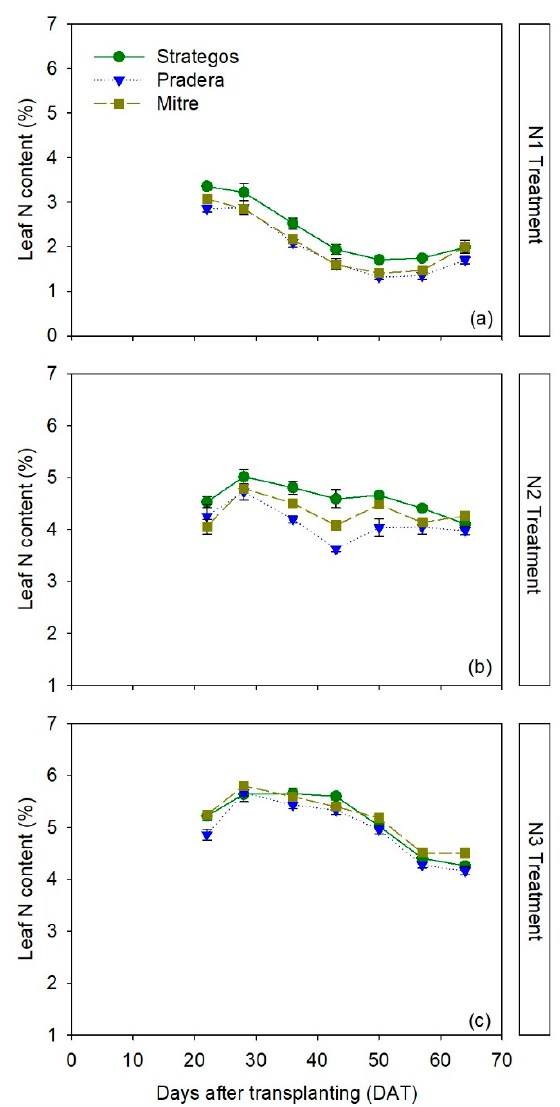
Figure 1. Temporal dynamics of leaf N content (%) of three cultivars of cucumber ( Cucumis sativus L. ‘Strategos’, ‘Pradera’ and ‘Mitre’) under three N treatments (N1 (panel a ), N2 (panel b ) and N3 (panel c )). Values are means ± SE.